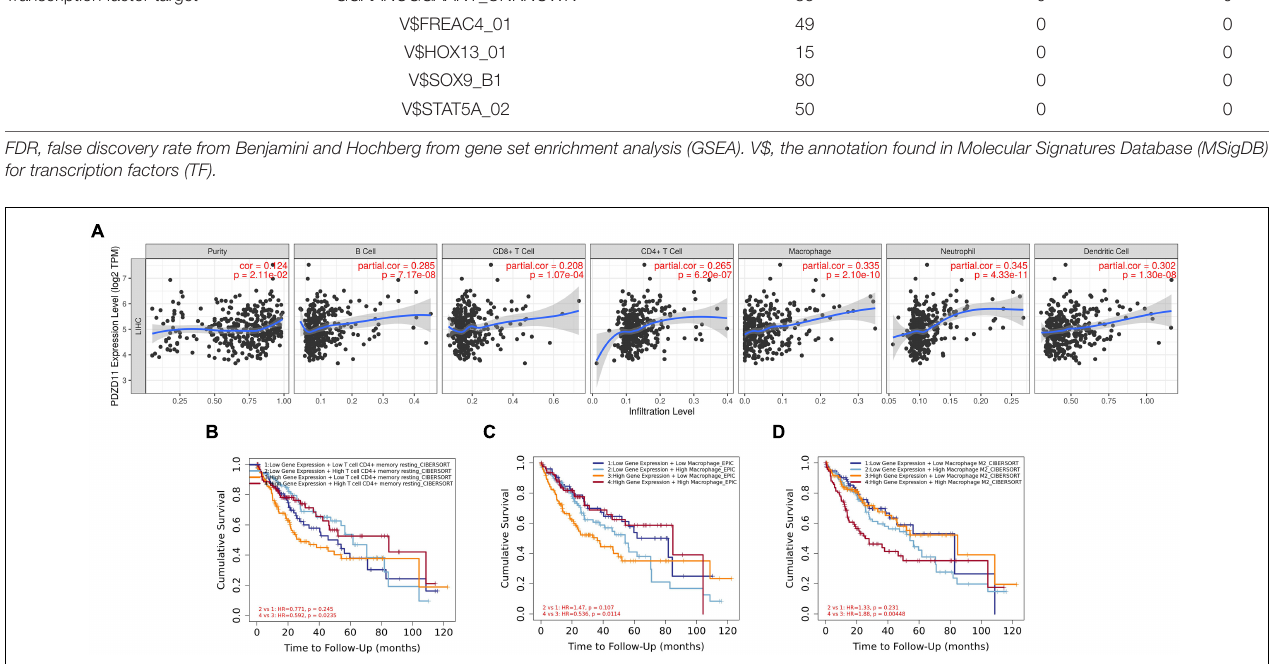
FIGURE 7 | Associations between mRNA expression of PDZD11 and immune infiltration in LIHC (TIMER2.0 database). (A) Association of PDZD11 expression with abundance of immune infiltrates (B cells, CD8 + T cells, CD4 + T cells, macrophages, neutrophils and dendritic cells). (B–D) The effect of PDZD11 expression in correlation with infiltration levels of immune cells on the prognosis of